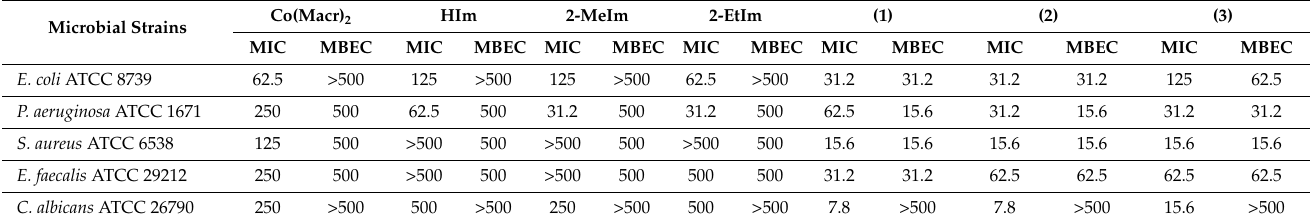
Table 6. Minimal inhibitory concentration (MIC)/minimal biofilm eradication concentration (MBEC) values ( µ g/mL) of the ligands, cobalt (II) methacrylate, and complexes ( 1 )–( 3 ). Microbial